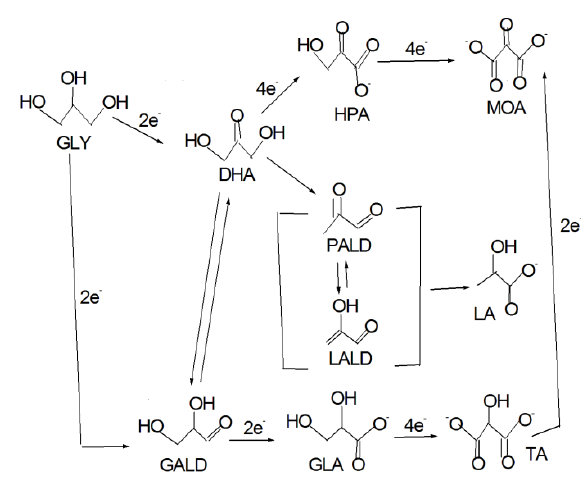
Figure 2. Representation of the possible pathways of glycerol (GLY) electro-oxidation on precious metal and precious metal-based catalysts in an alkaline medium with the oxidation of primary and secondary OH and in the absence of C–C bond cleavage, based on the pathways reported in various schemes [18–21,28,29].